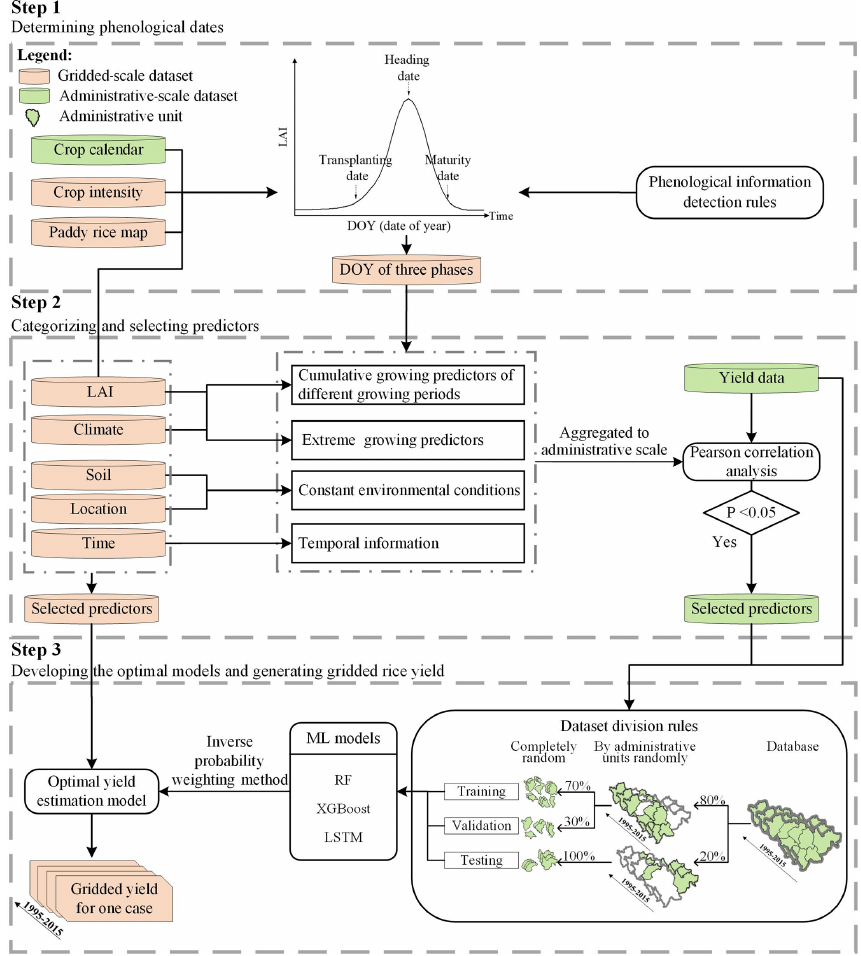
Figure 2. Flowchart for generating long-term and high-resolution gridded rice yields by incorporating multisource data into ML models for one case. All 27 cases followed these steps and were combined to obtain the AsiaRiceYield4km